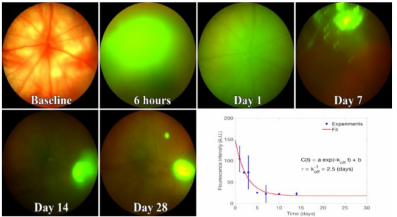
Figure 6. Kinetics of fluorescent EVs in the vitreous. Representative images from 3-4 rats injected with Exo-glo and imaged using Phoenix Micron IV. Bottom right, fluorescence decay curve with calculated parameters. From fitting the curve, the lifetime of EVs in the vitreous is about 2.5 days. Image intensity on Y-axis is mean +/ − SD.